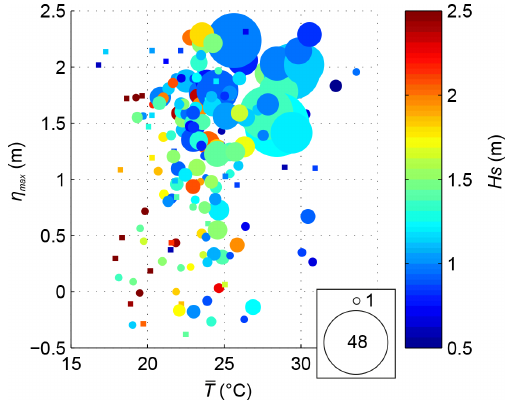
Figure 11. Daily maximum tidal elevation η max between 15 and 19h versus daily mean air temperature averaged between 11 and 19h T , with significant wave height averaged between 11 and 19h coloured and circle size proportional to the daily number of shore- break-related injuries. Squares show days when there was no shore- break-related